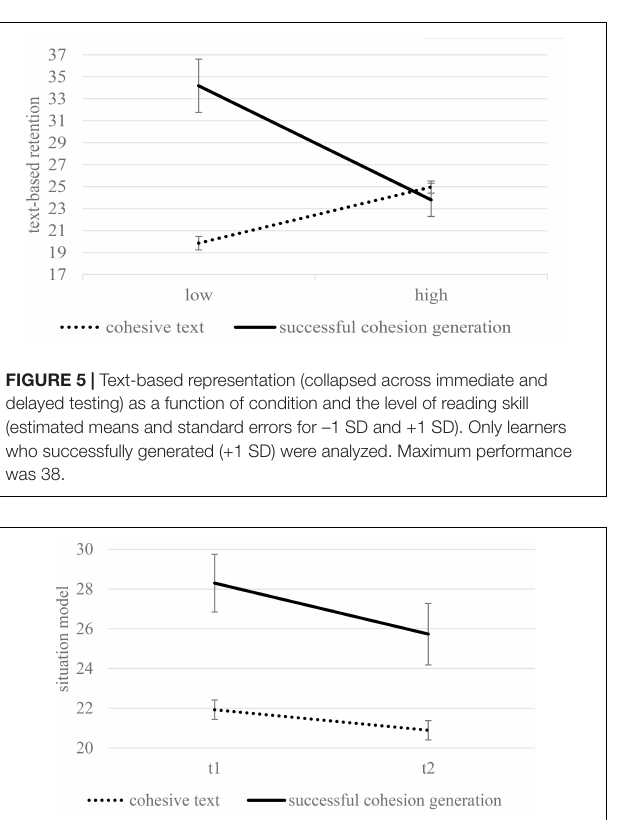
FIGURE 6 | Situation model as a function of condition and delay when controlling for reading skills (estimated means and standard errors). In contrast to Figure 2 , only learners who successfully generated (+1 SD) were analyzed. Maximum performance was